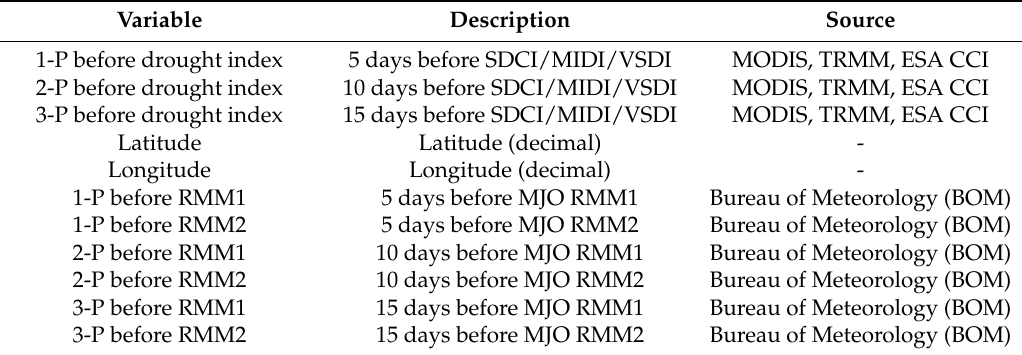
Table 1. Description of Input variables used in the proposed models with Madden–Julian Oscillation (MJO) for three drought indices: Scaled Drought Condition Index (SDCI), Microwave Integrated Drought Index (MIDI), and Very Short-term Drought Index